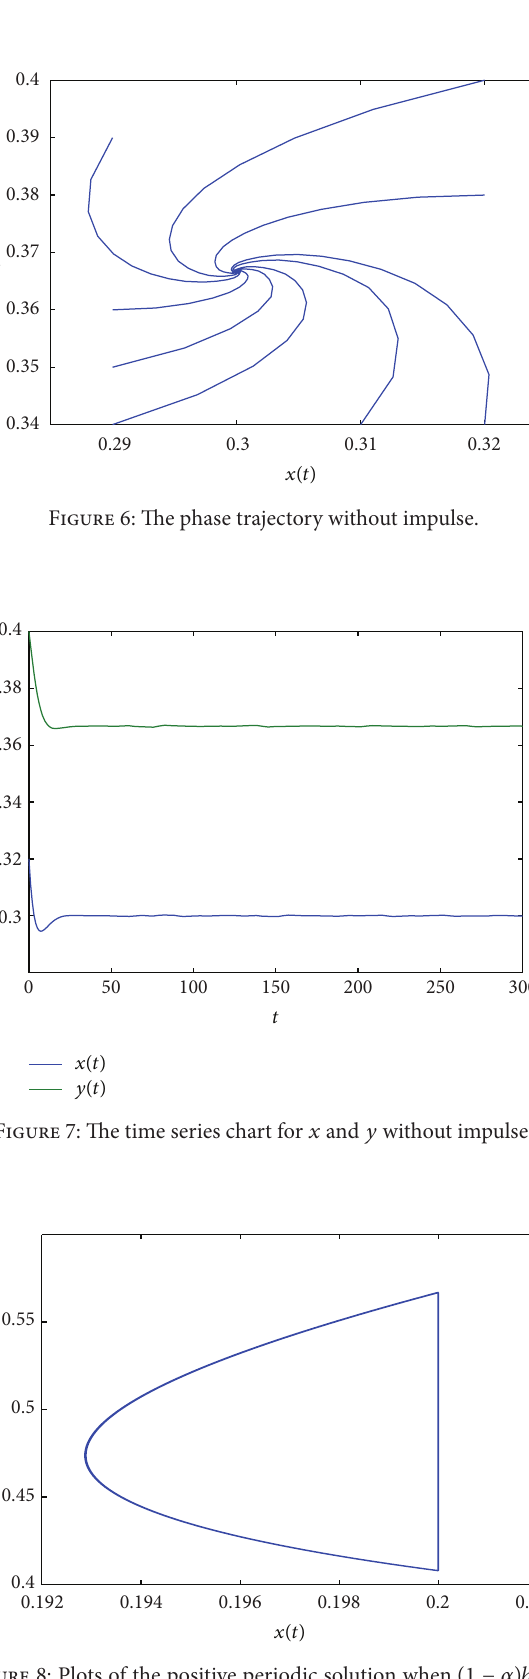
= 0.2 , ℎ = 0.28 , 𝛼 = 0.4 , 𝛽 = 0.2 , and 1 2